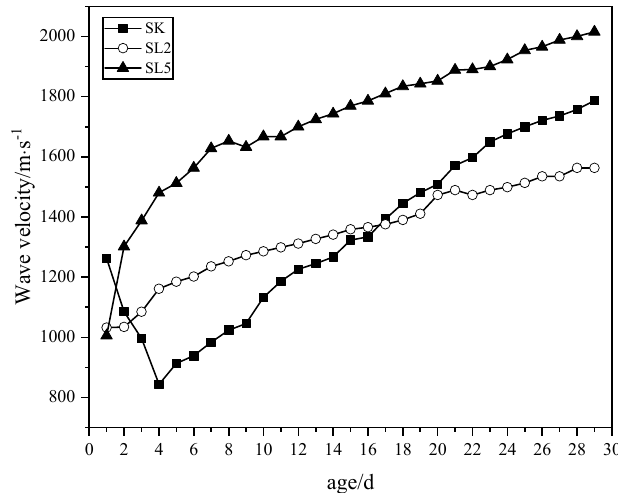
Figure 6. Age − wave velocity relationship.